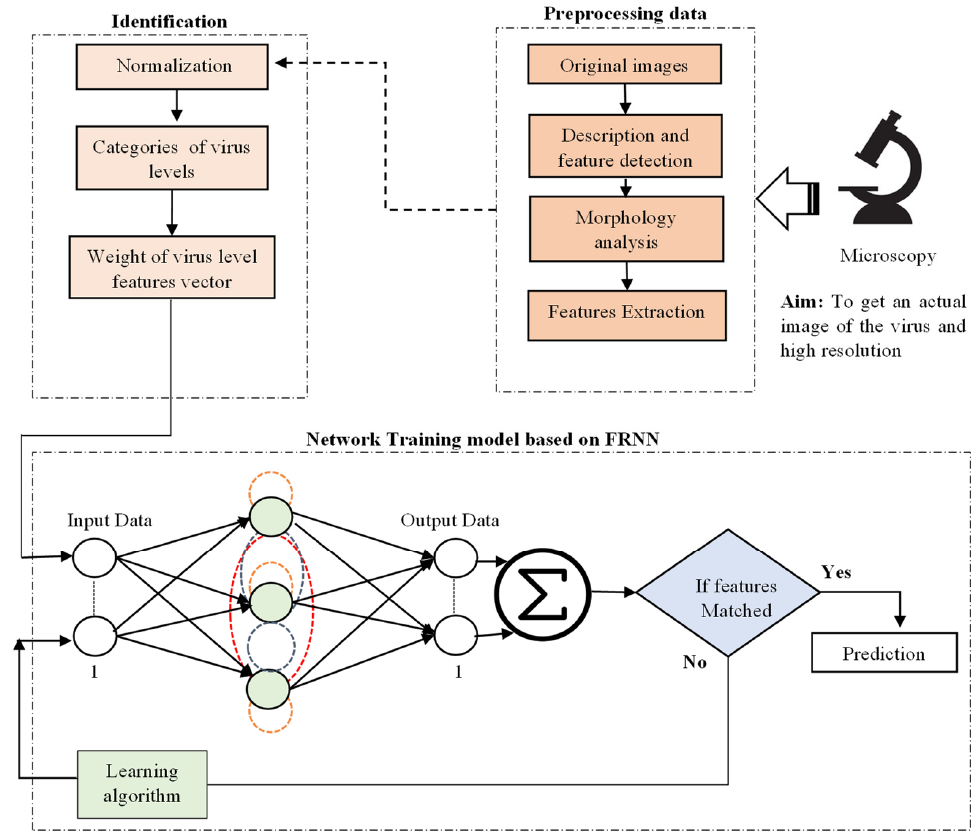
Figure 4. The SARS-CoV-2 prediction model illustrates the virus levels using the full recurrent neural network (FRNN) algorithm.